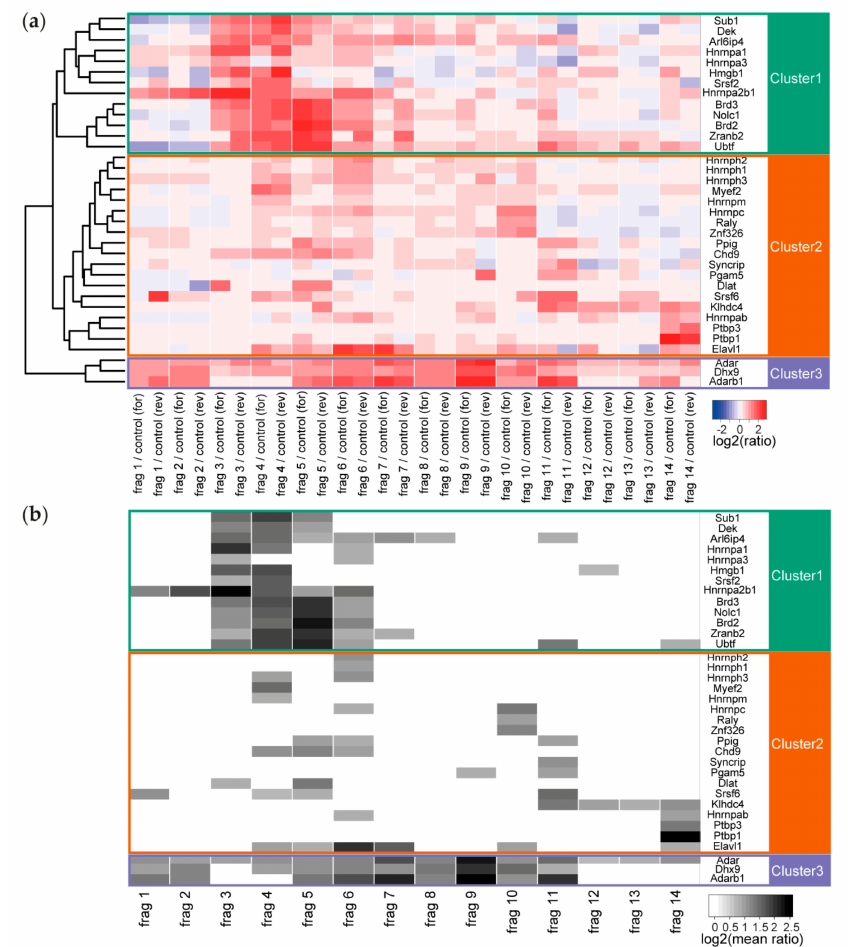
Figure 3. ( a ) Heatmap of all values for the enriched RNA-binding proteins at all Malat1 fragments (including the forward and reverse experiment). Cluster tree on the left edge reveals three major clusters representing di ff erent binding patterns of the interactors. ( b ) Filtered heatmap representation of the interactors only when fulfilling the 1.7-fold enrichment